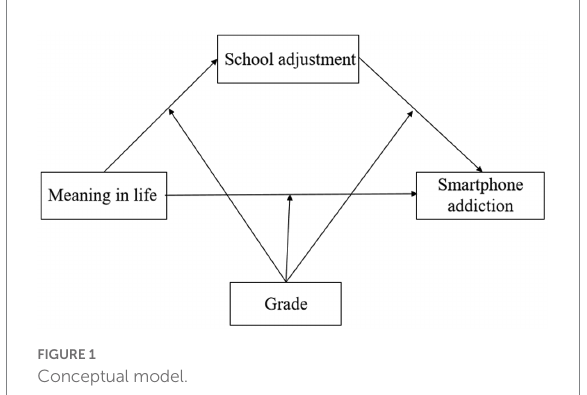
FIGURE 1 Conceptual